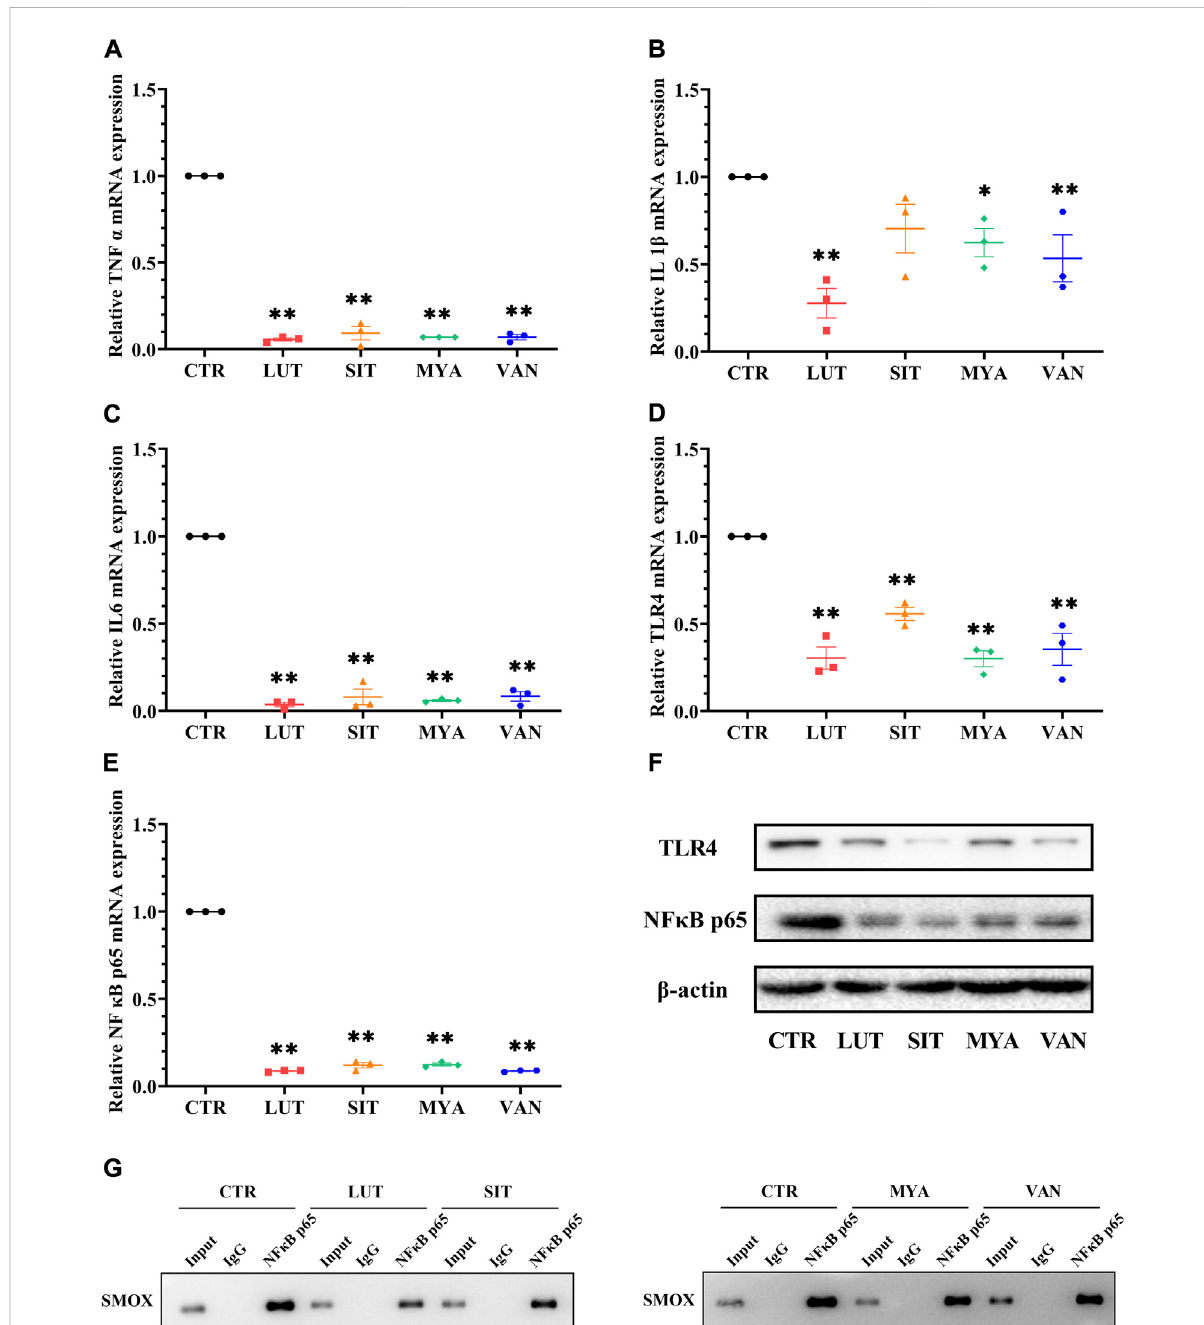
FIGURE 12 Effect of YFBP active ingredients on the expression of the in fl ammatory mediator and the regulation of in fl ammatory signaling. (A – E) mRNA expression of TNF α , IL-1 β , IL-6 TLR4, and NF- κ B p65 in the tumor tissue was measured by qRT-PCR. (F) Protein expression of TLR4 in the